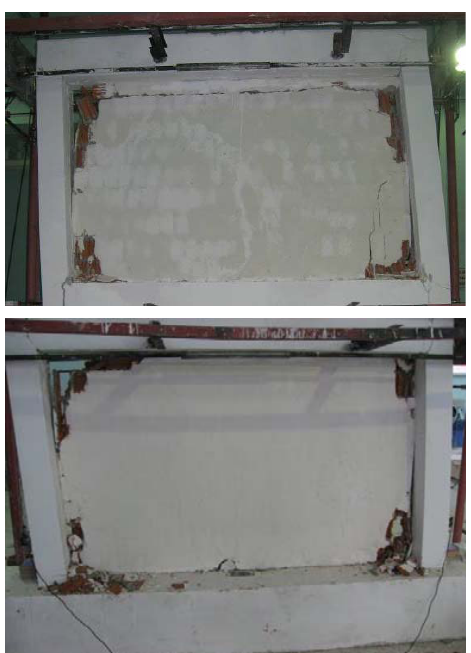
Figure 9 Load-top displacement hysteresis curve of SPS1